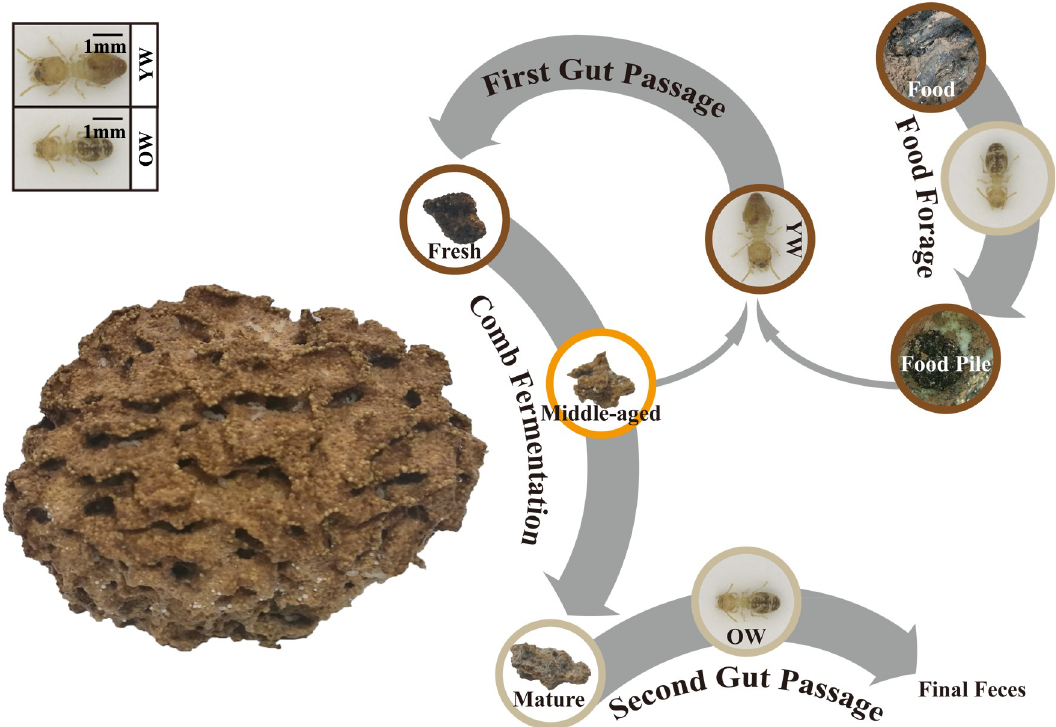
Fig 1. The food processing pathway in fungus-cultivating termite ( O . formosanus ). Food forage: old workers collect the food from outside environment and pile in the colony; First gut passage: young workers ingest the foraged material along with nodules (conidia) from middle-aged fungus-comb and excrete primary feces on the top surface of the comb to establish fresh comb; Comb fermentation: fungus grows on the fresh comb, degrade it efficiently to convert it into middle-aged comb, where new nodules are produced [12, 13]. The comb turns to mature in 45 days [12]; Second gut passage: old workers ingest mature comb and excrete final feces. YW, young worker; OW, old worker.